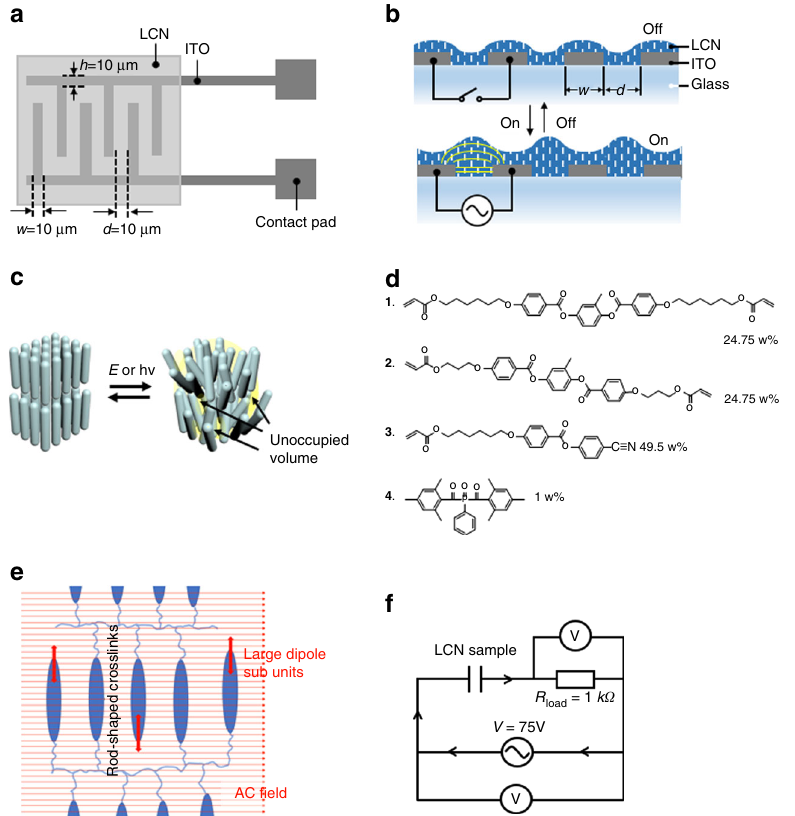
Fig. 1 Principle of electrically-driven surface topographies. a Schematic representation of the interdigitated indium tin oxide (ITO) electrode array on glass and its dimensions. b A lateral electric fi eld is coupled to the polymer fi lm by the electrodes from a , to induce the formation of protrusions. c Schematic representation of the formation of molecular voids upon stress – induced reduction of molecular order in an LCN. d Chemical composition of the liquid crystal mixture to form the LCN by photopolymerization. e Schematic representation of the LCN polymer. The orientation of the LC molecules perpendicular to the AC fi eld provides the torque that induce the oscillatory stresses. f The electric circuit employed drives the sample deformation and measures the current fl ow. The LCN coating stores energy when placed in the external electric fi eld and functions as a capacitor. A resistor with known resistance is in series with the sample to measure the current by means of an oscilloscope. An alternating voltage source drives the sample and the actual applied voltage is